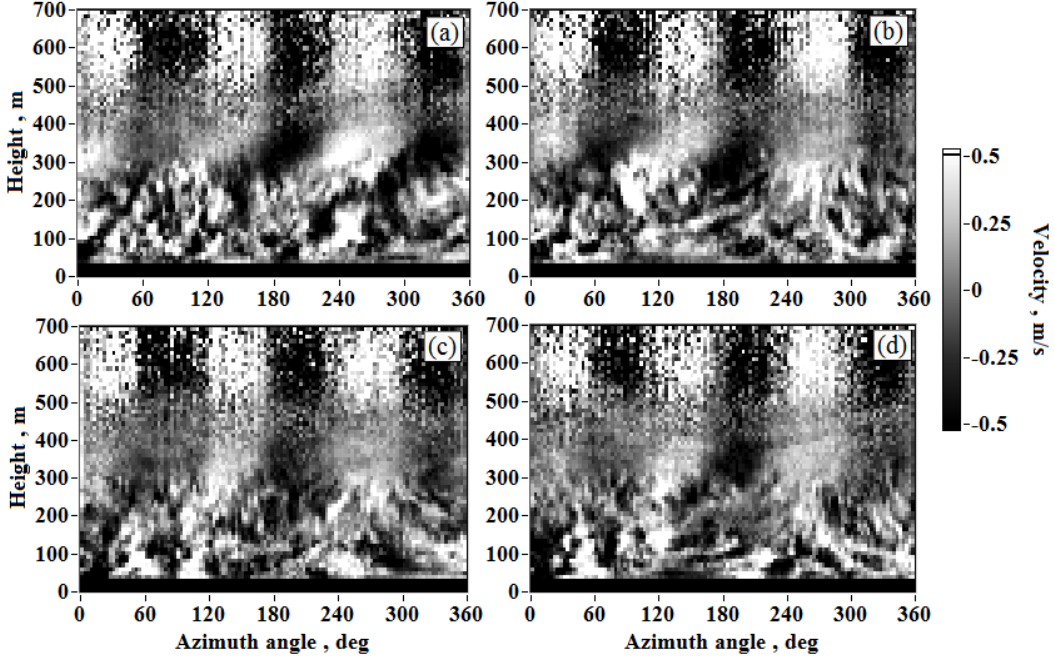
( h ) as obtained from k / sin ϕ , θ m ; n L